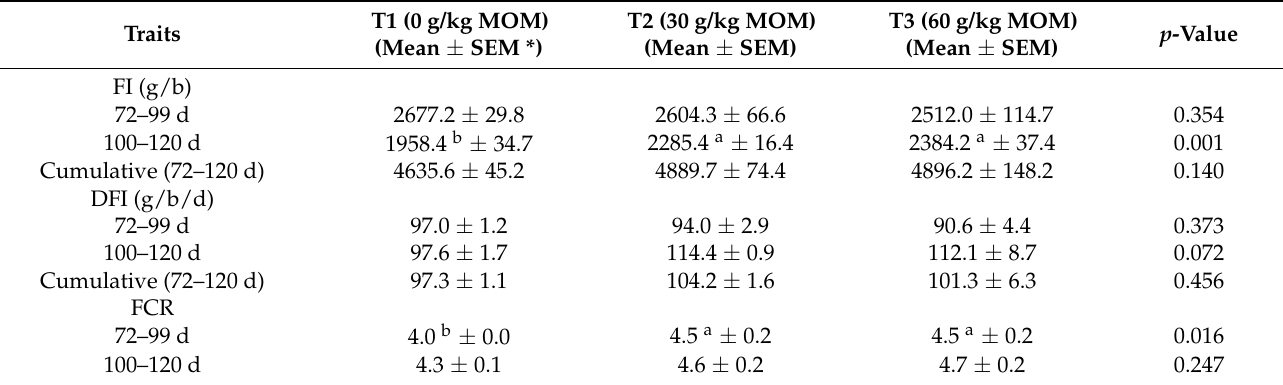
Table 4. Feed intake (FI), daily feed intake (DFI), feed conversion rate (FCR), and mortality rate (MR) of slow-growing Dominant CZ Blue D 107 male chickens raised with Moringa oleifera meal (MOM)